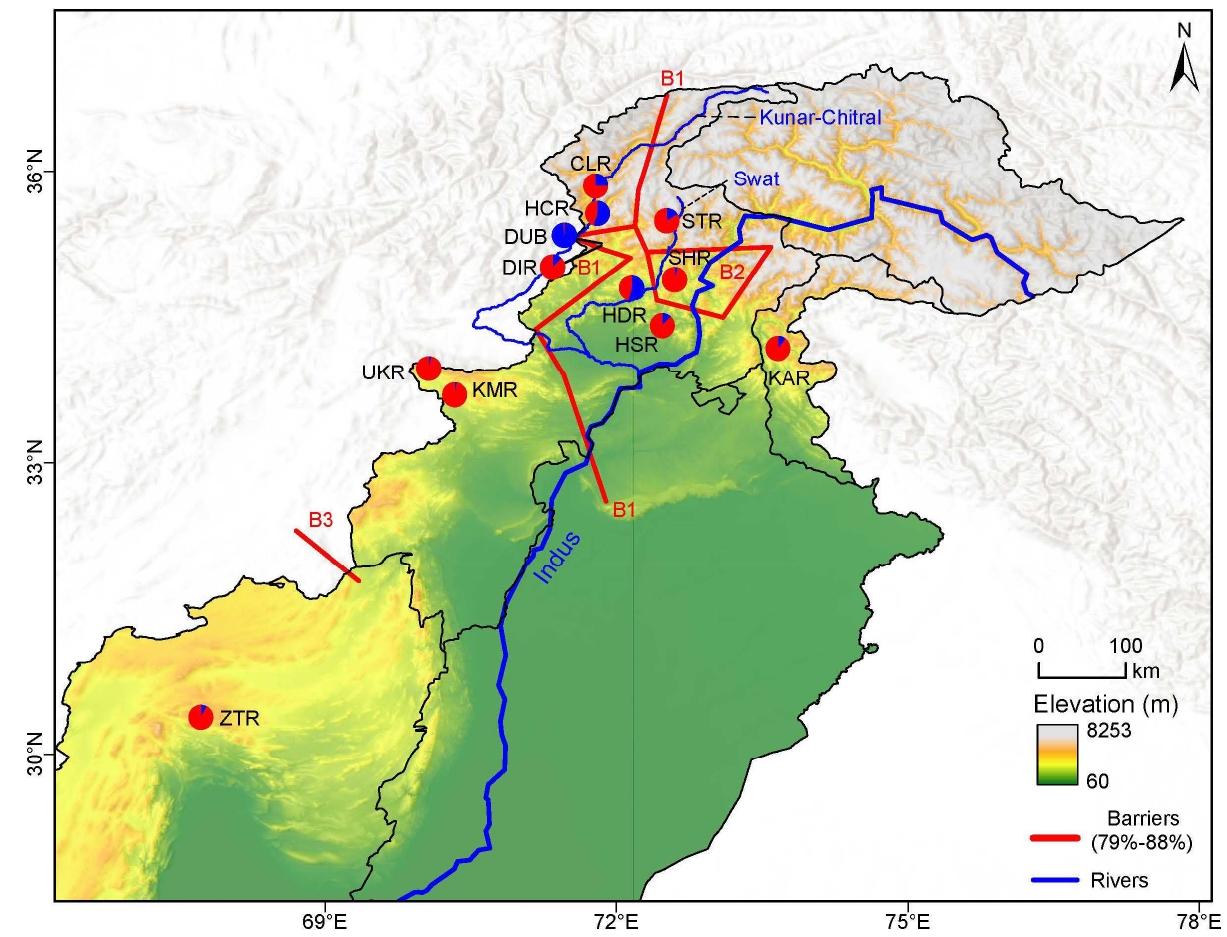
Figure 4. Spatial genetic structure of walnut in Pakistan. Pie color and proportion is in accordance to with genetic structure analysis results (Figure 3a). The three main detected barriers (B1, B2 and B3) are shown in red line, with the thin black lines indicating the administrative boundaries.